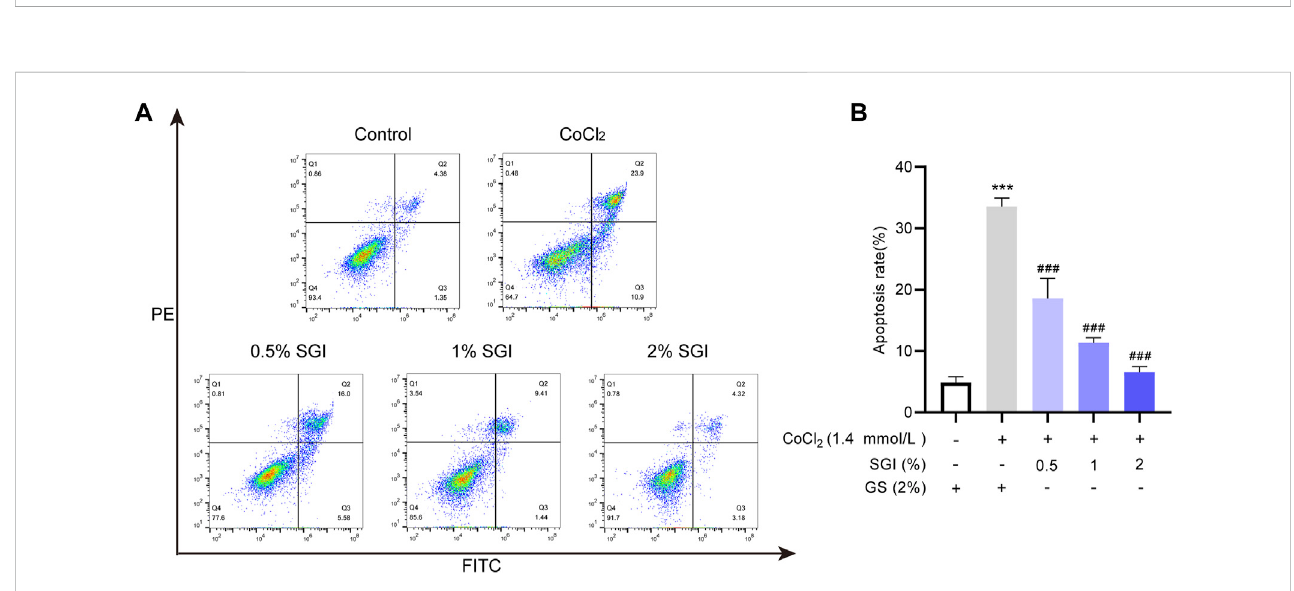
FIGURE 8 SGIprotectsHUVECsfromCoCl 2 -inducedapoptosis.Theapoptosisratewasmeasuredby fl owcytometry (A) ,andhistogramsindicatetheproportionof apoptosis (B) . *** p < .001 vs. the control group; ### p < .001 vs. the CoCl 2